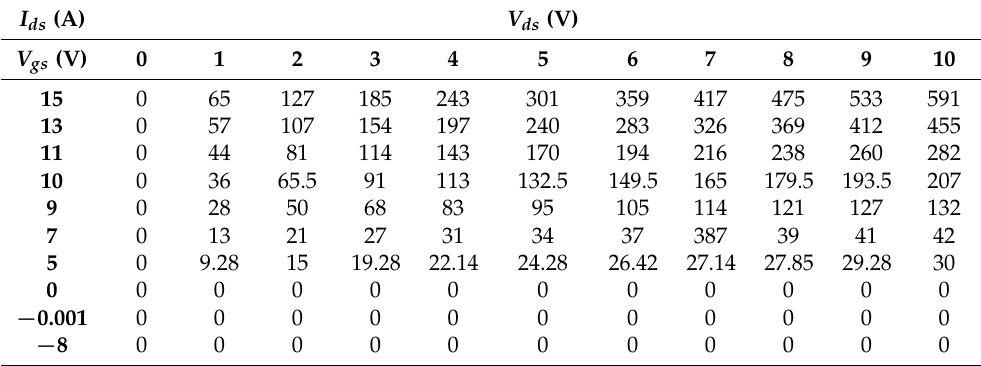
Table 2. First quadrant SiC MOSFET I ds current with respect to the V gs & V ds voltages at 25 ◦ C.